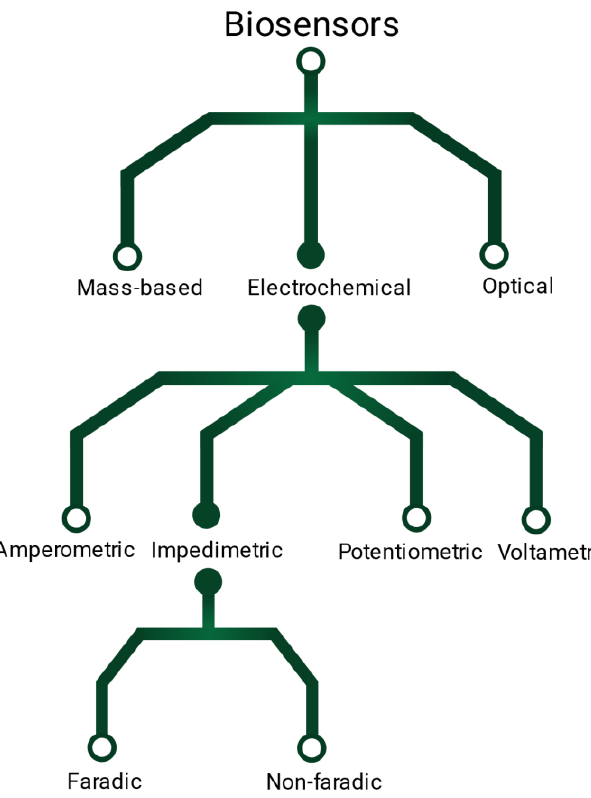
Figure 1. Illustration of the different types of electrical sensors.